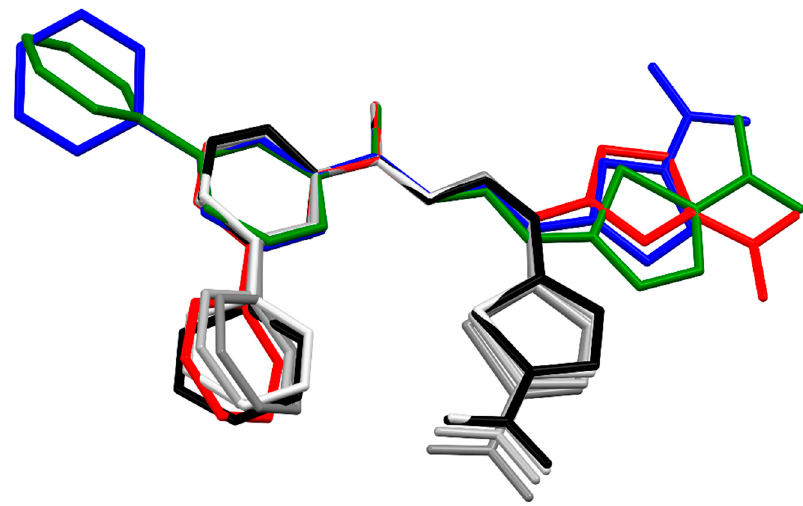
Figure 11. Overlay of molecules for all determined structures; 3a —red, 3b —light grey, grey, dark grey, black green and green, 4a —blue, and 4b —green. H atoms were omitted for clarity.